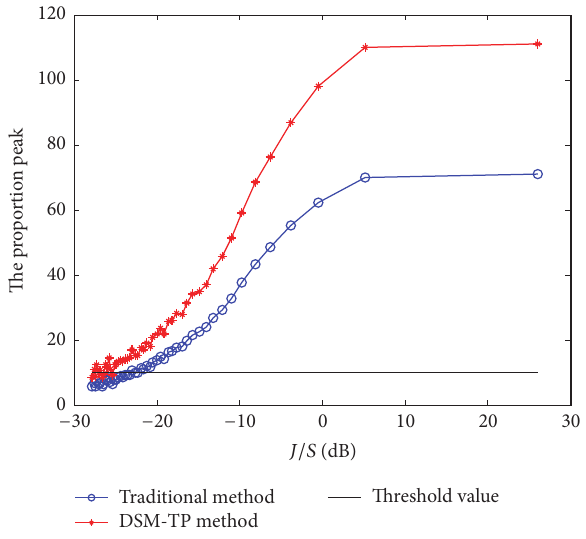
Figure 10: Proportion peak for changing S/J .